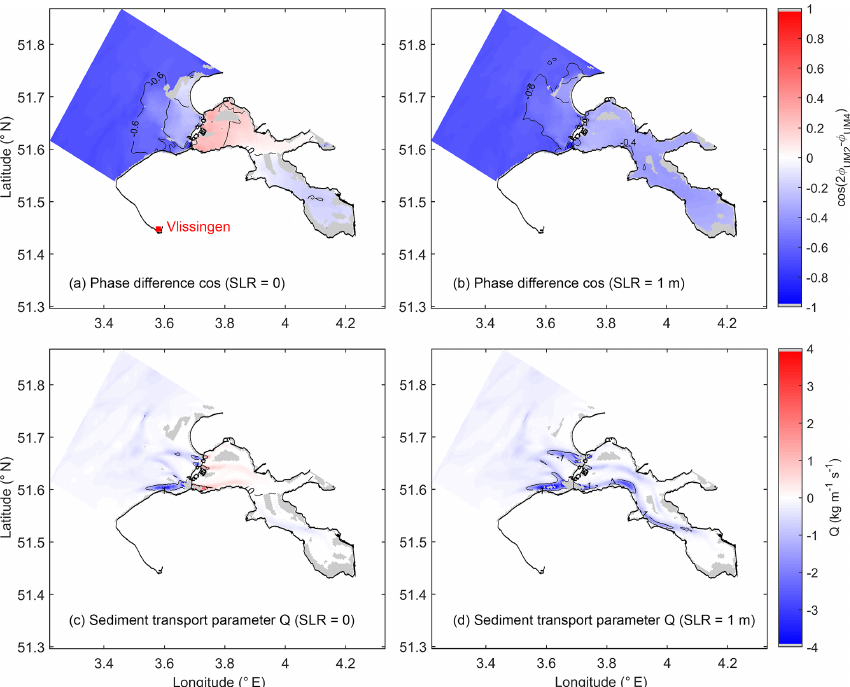
Figure 7. (a, b) Cosine of M2–M4 velocity phase difference and (c, d) sediment transport quantity Q in the baseline and 1m SLR scenarios. Positive (negative) Q denotes landward (seaward) transport. Tidal flats are shown in